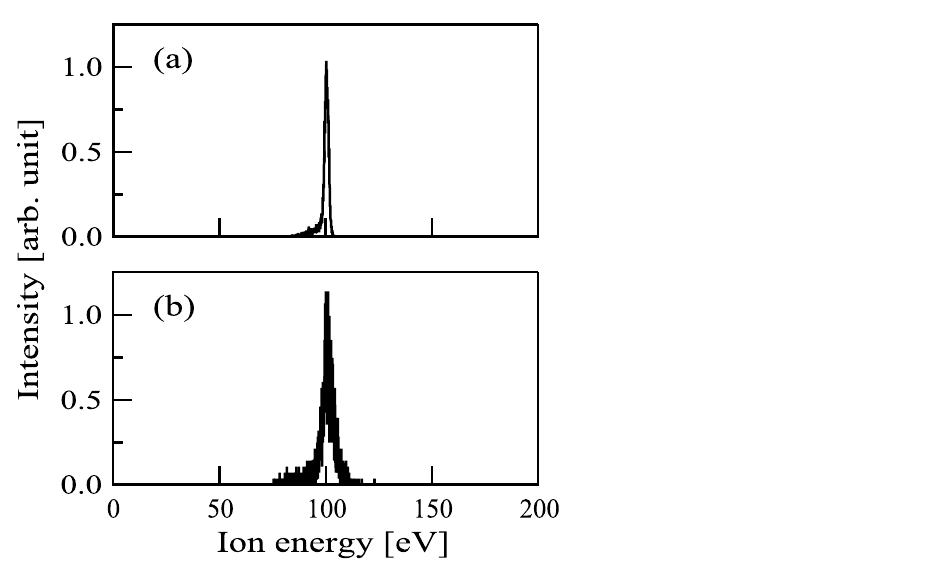
Fig 3. The energy spectra of (a) Ar + and (b) N + ion beams.